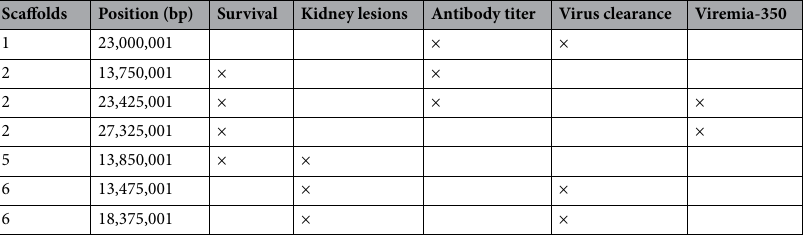
Table 3. Candidate regions (spans ± 1 Mb) identified by overlapping selective signals of Z(F ST ) and log 2 (θ π ratios ) that were shared by two or more groups.